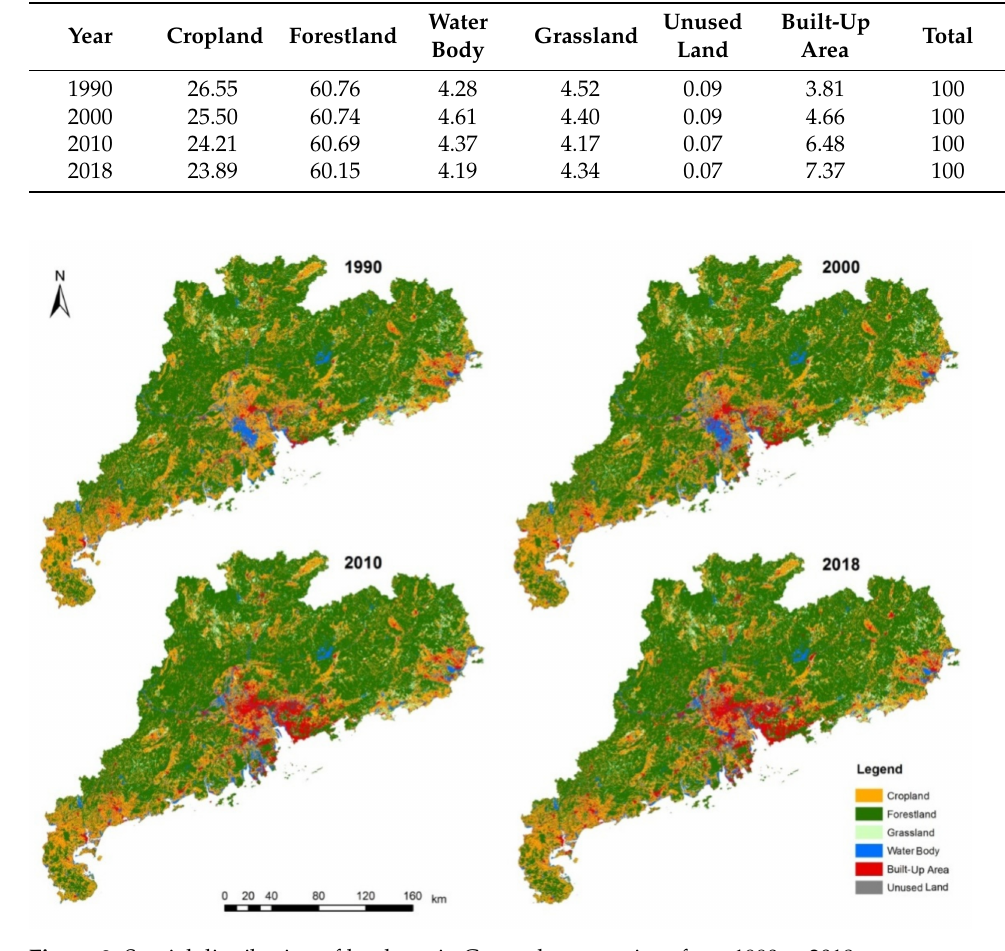
Figure 2. Spatial distribution of land-use in Guangdong province from 1990 to